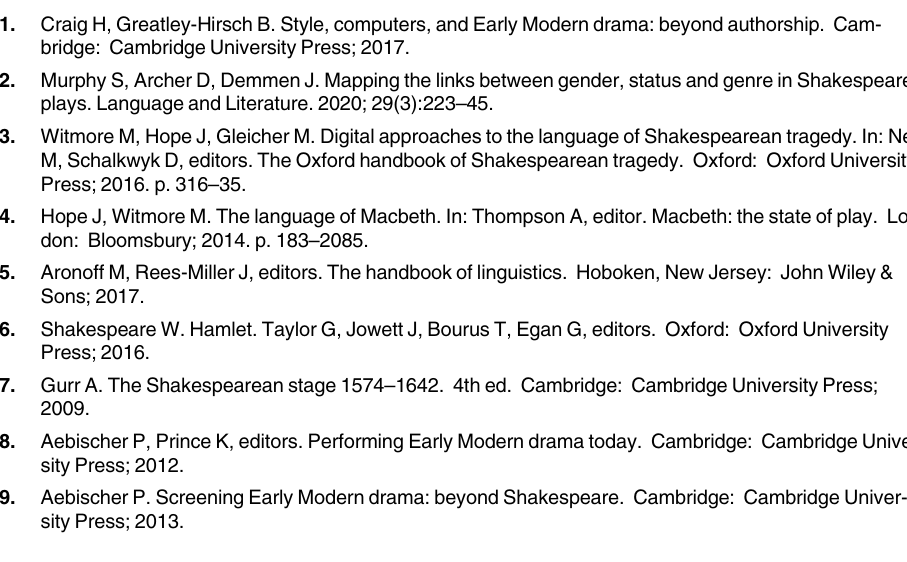
S5 File. Summary data file containing play mode, median and mean of speech length in words, with play